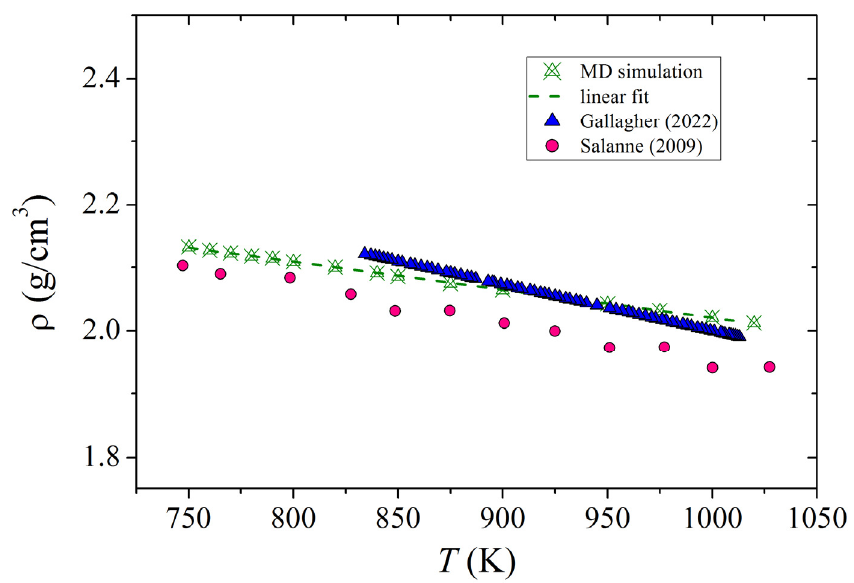
Figure 4. Simulated and experimental densities of FLiNaK system; dash line shows the linear fit of our MD data; blue triangles show results of experiment [28], pink dots represent the simulated data obtained in the polarizable MD model [29].